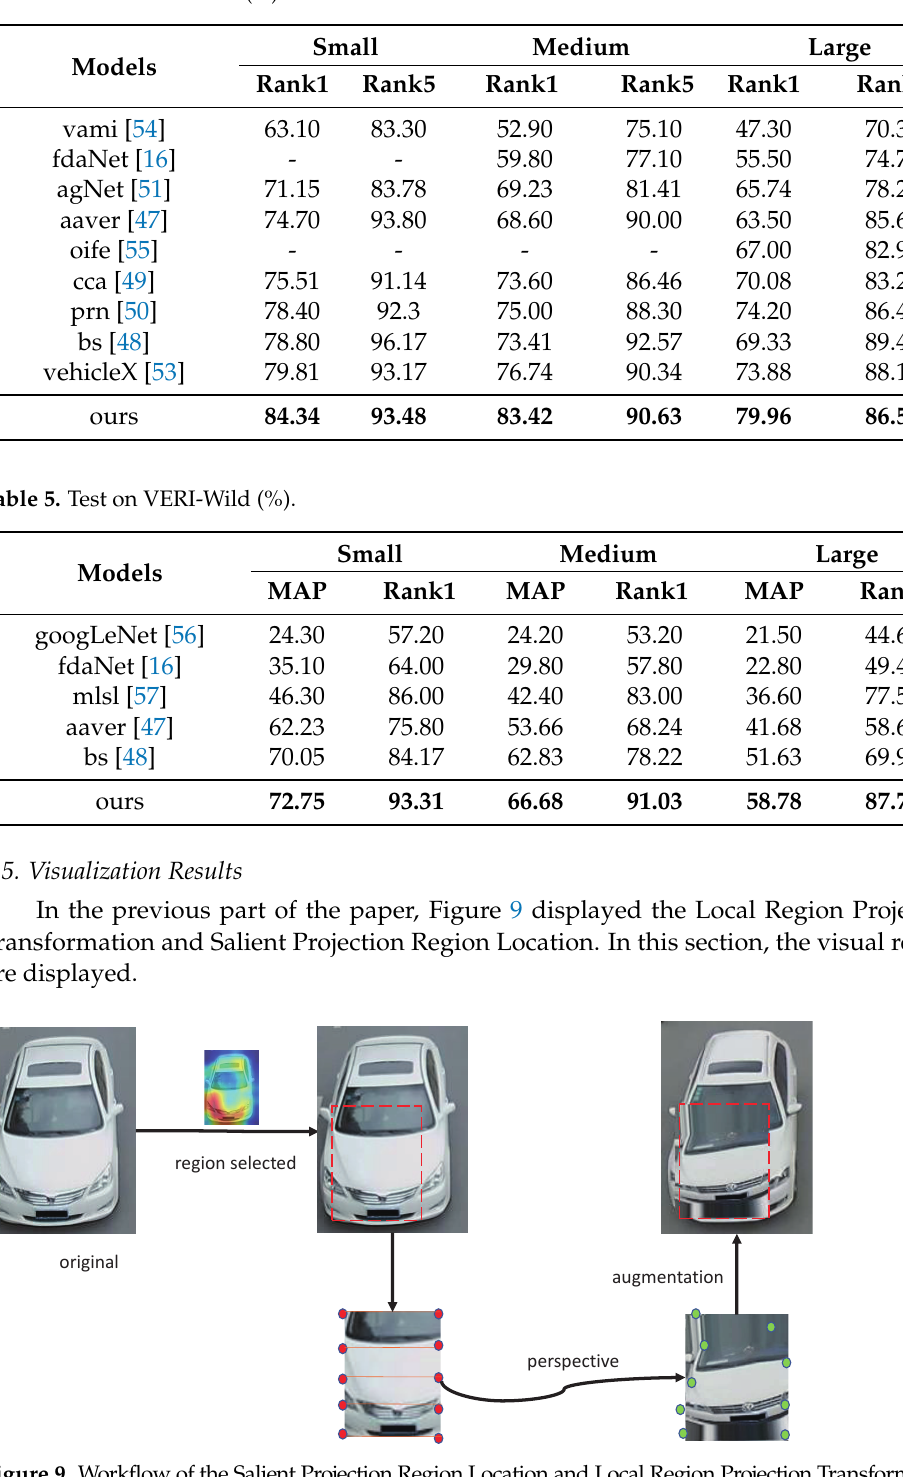
Table 4. Test on VehicleID (%).